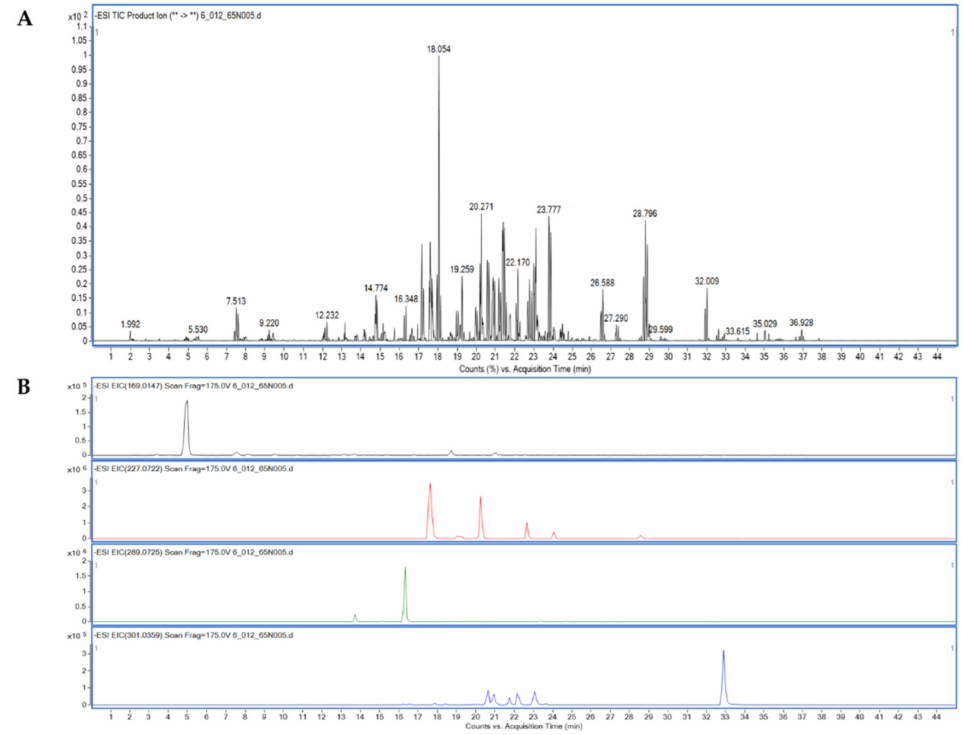
Figure 2. LC-MS/MS analysis. Total ion chromatogram (TIC) of phenolic compounds in BsE fraction ( A ) and extracted ion chromatogram (EIC) of four isolated compounds in Section 2.4, including gallic acid, resveratrol, epicatechin, and quercetin, respectively ( B